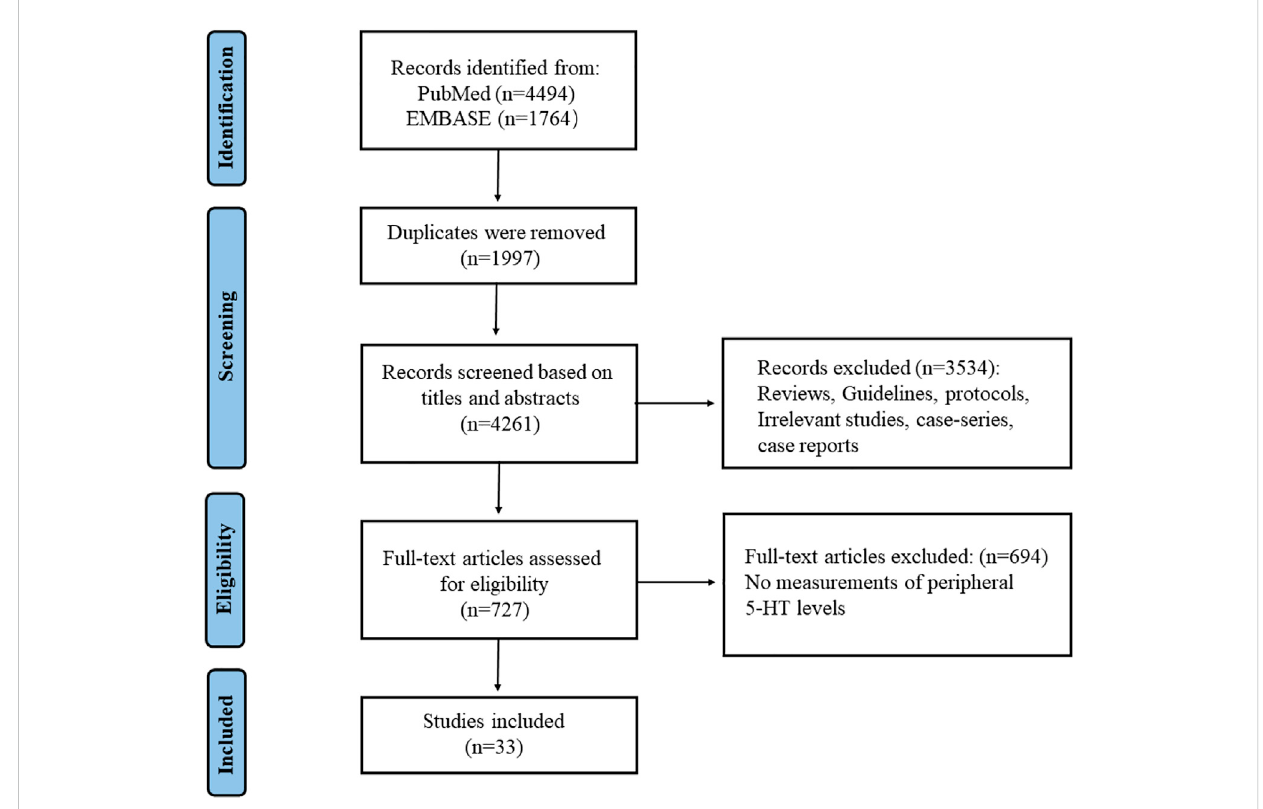
The search process and the screening of the articles for identifying the eligible